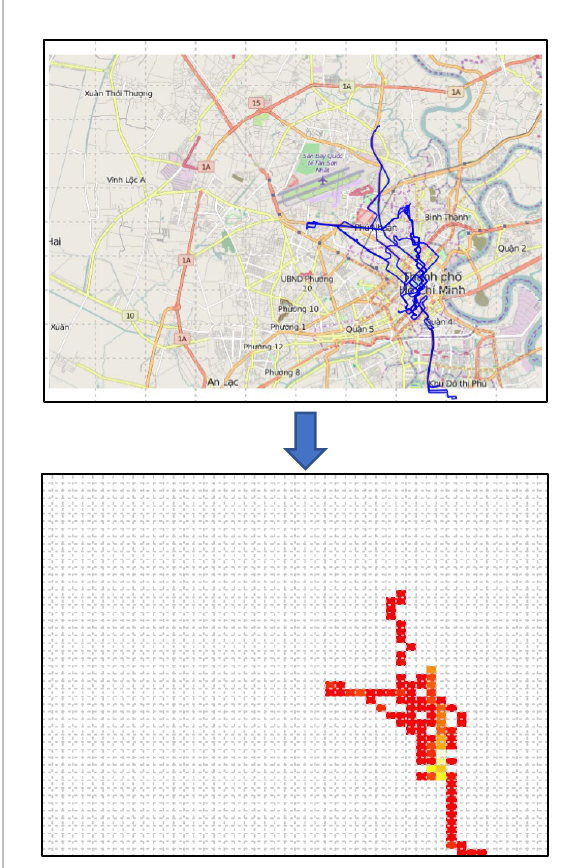
Fig.3. An illustration of histogram-based feature extracted from a trajectory. The grid size is 50x50.